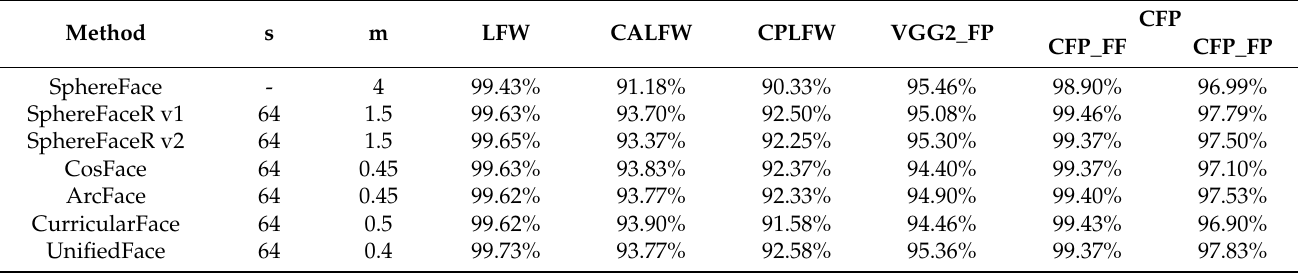
Table 7. Performance comparison of UnifiedFace with state-of-the-art methods in using VGGFace2 as the training